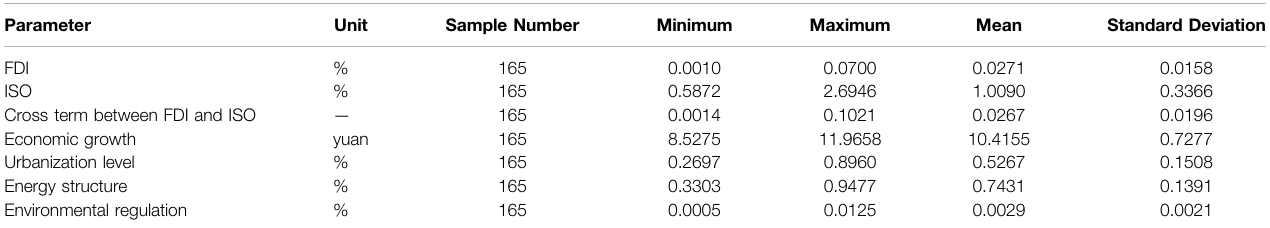
TABLE 2 | Statistics on the factors affecting